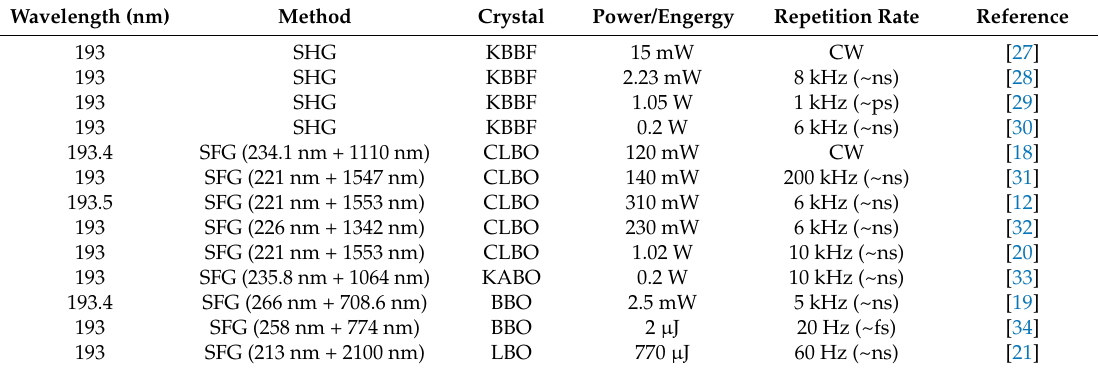
Table 2. Typical results of the solid-state DUV laser at 193 nm (CW: continuous-wave; KABO: K 2 Al 2 B 2 O 7 ). Wavelength